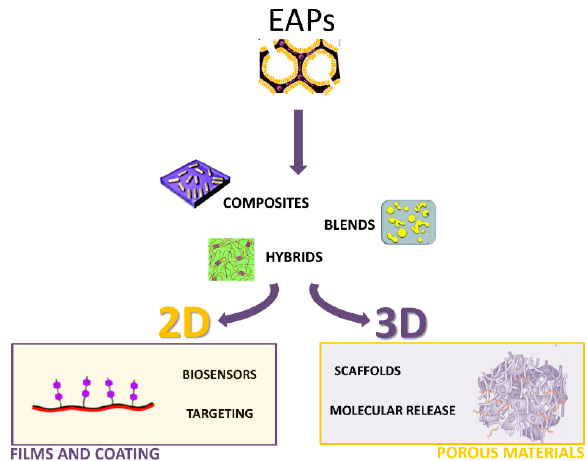
Figure 3. Scheme of EAP processing modalities to fabricate 2D or 3D devices for different applications in the biomedical field.